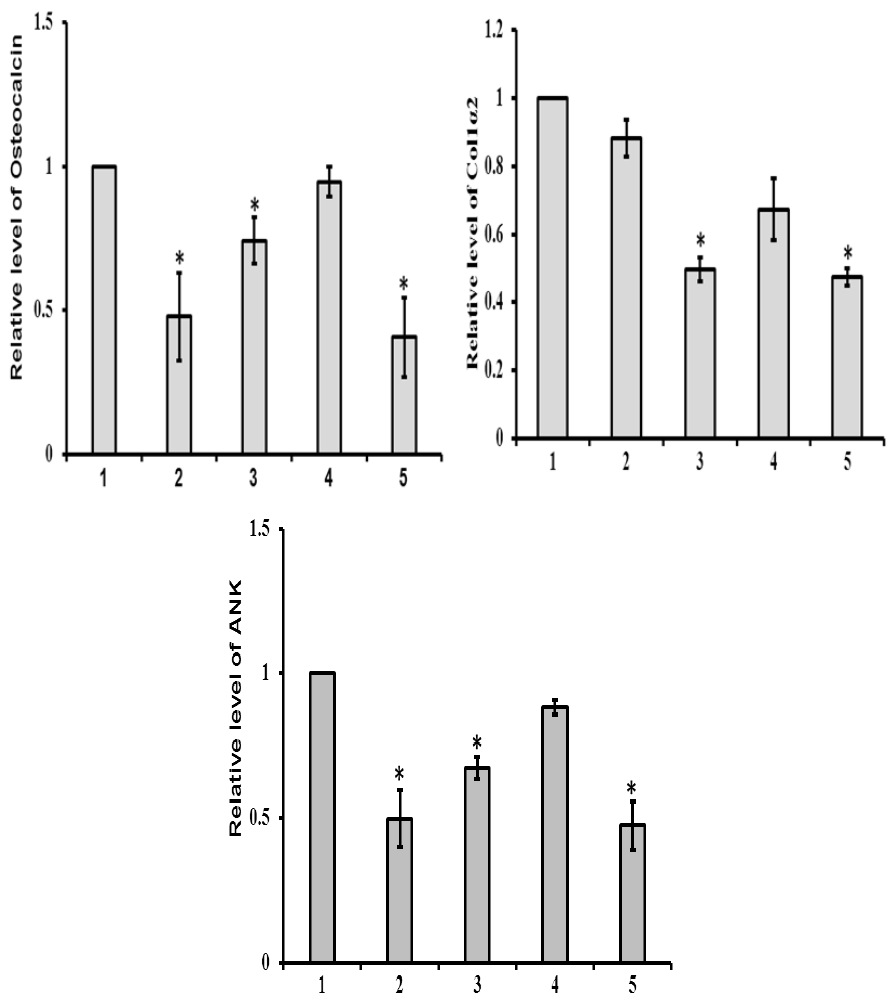
Figure 10. Protein expression of differentiated MSCs treated with sRANKL and PTHrP. 1 — control, 2 — sRANKL50, 3 — PTHrP50, 4 — sRANKL10 – PTHrP10, 5 — sRANKL50 – PTHrP50. * p < 0.05 vs. control.